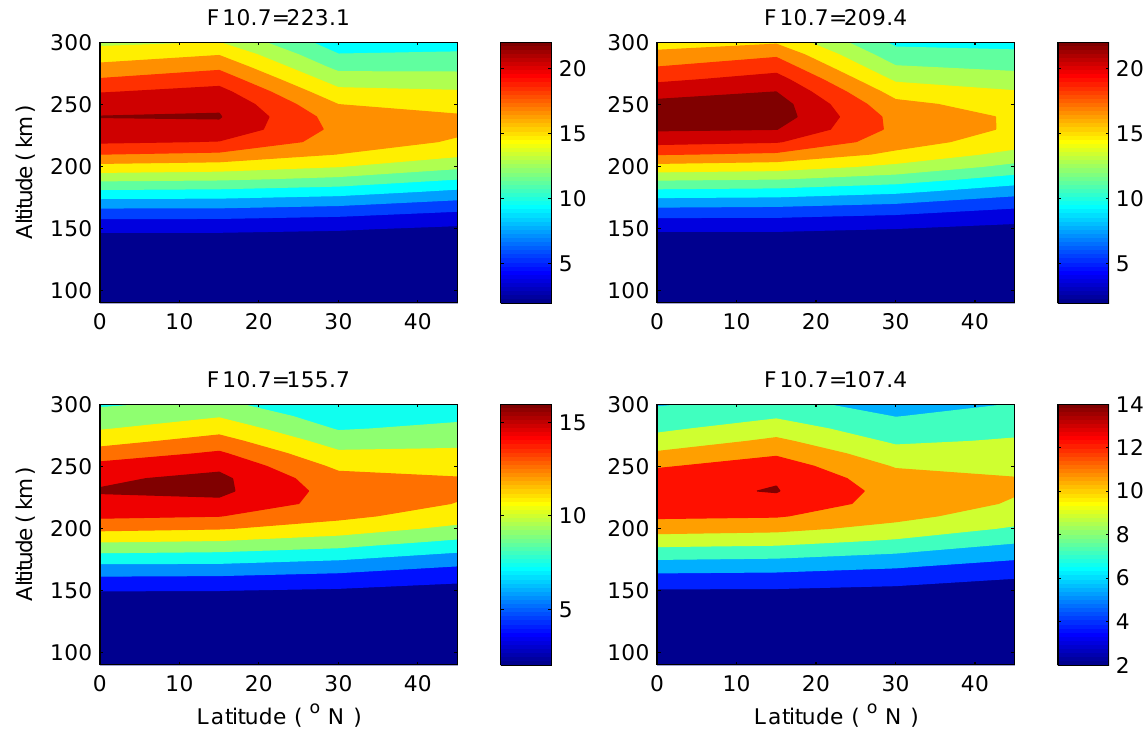
Fig. 4. Modeled morphology of 7320 ˚A between 0 ◦ and 45 ◦ N on 3 April for different solar activity levels at 10:00h local time.